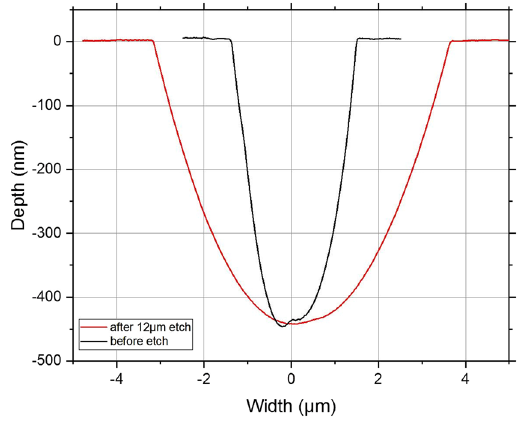
Figure 3. Scratch depth profiles before and after 12 µ m deep acid etching, obtained by post treatment from the AFM images exposed in Fig.